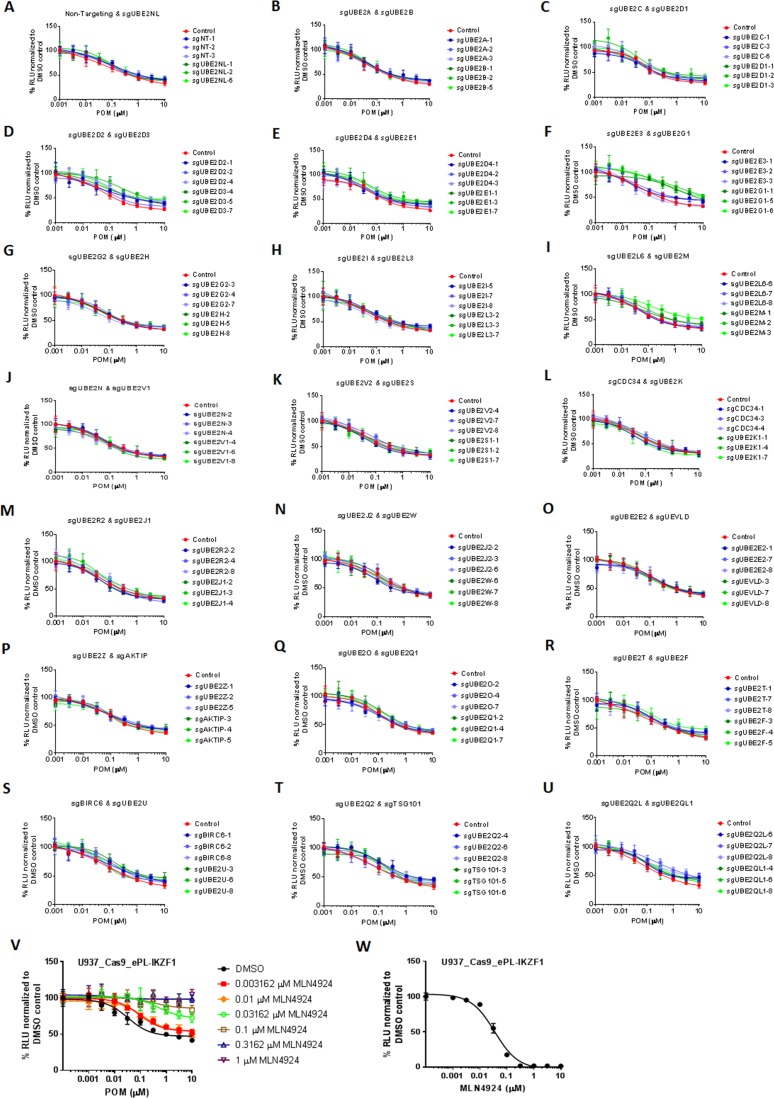
The effect of individual knockout of each of the 41 annotated E2 enzymes or inactivation of cullin neddylation with MLN4924 on pomalidomide-induced destruction of IKZF1.(A–U) Chemiluminescent measurement of ePL-IKZF1 protein expression level in U937_Cas9_ePL-IKZF1 parental cells or cells expressing non-targeting or E2-specific sgRNA. Cells were treated with DMSO or an increasing concentrations of POM for 16 hr. (V) Chemiluminescent measurement of ePL-IKZF1 protein expression level in U937_Cas9_ePL-IKZF1 cells treated with DMSO or an increasing concentrations of POM in the presence or absence or MLN4924 at the indicated concentrations for 16 hr. Data are presented as mean ± SD, n = 4 technical replicates. (W) Cell proliferation of U937_Cas9_ePL-IKZF1 cells treated with DMSO or MLN4924 at the indicated concentrations for 48 hr. Cell proliferation was determined by CTG. Data are presented as mean ± SD, n = 4 technical replicates. Results shown in V and W are representative of three independent experiments.10.7554/eLife.40958.007Figure 1—figure supplement 2—source data 1.ePL luminescence signal shown in Figure 1—figure supplement 2A–V, and CTG luminescence signal shown in Figure 1—figure supplement 2W.